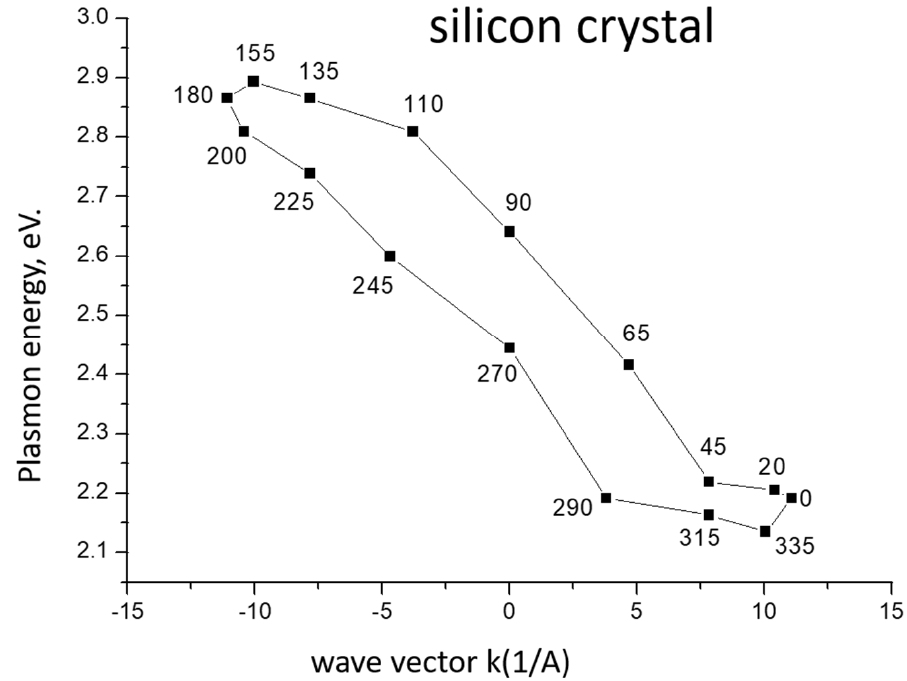
Figure 9. Dispersion of surface plasmons for a silicon single crystal with indication of azimuthal angles β in degrees for each experimental point.